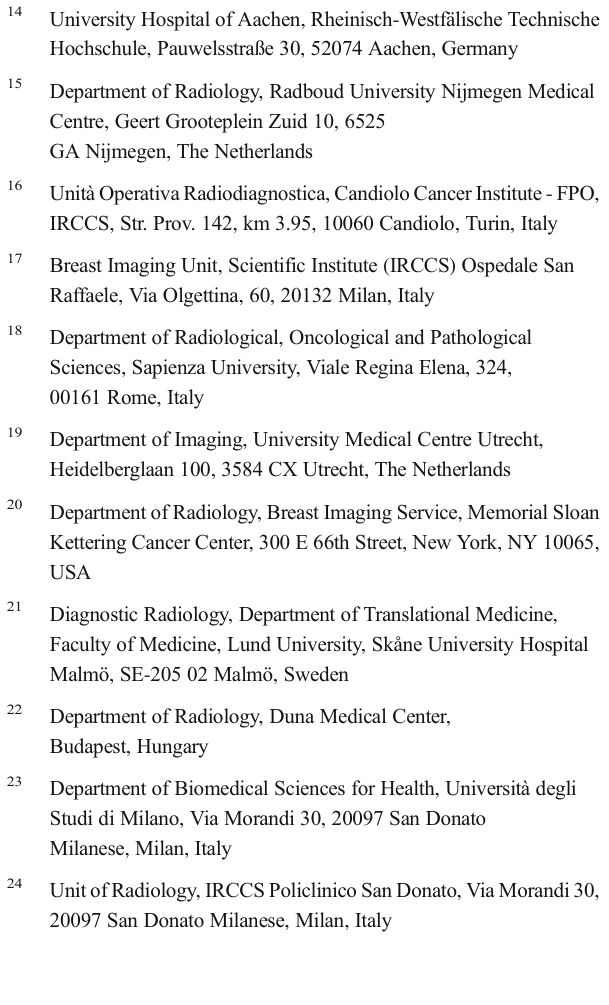
Referenzzentrum Mammographie München and FFB